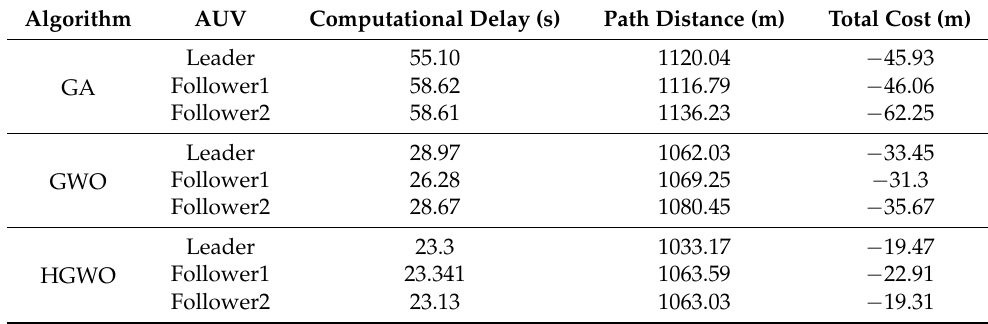
Table 2. Analysis of the GA, GWO and HGWO performances for path planning of multiple AUVs.